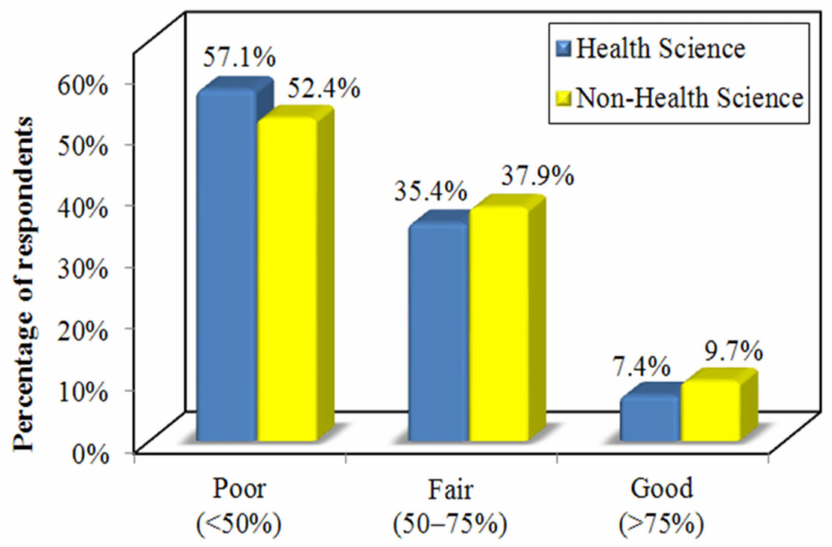
Figure 1. Bar graph showing the comparison of the level of knowledge scores among the health science and non-health science